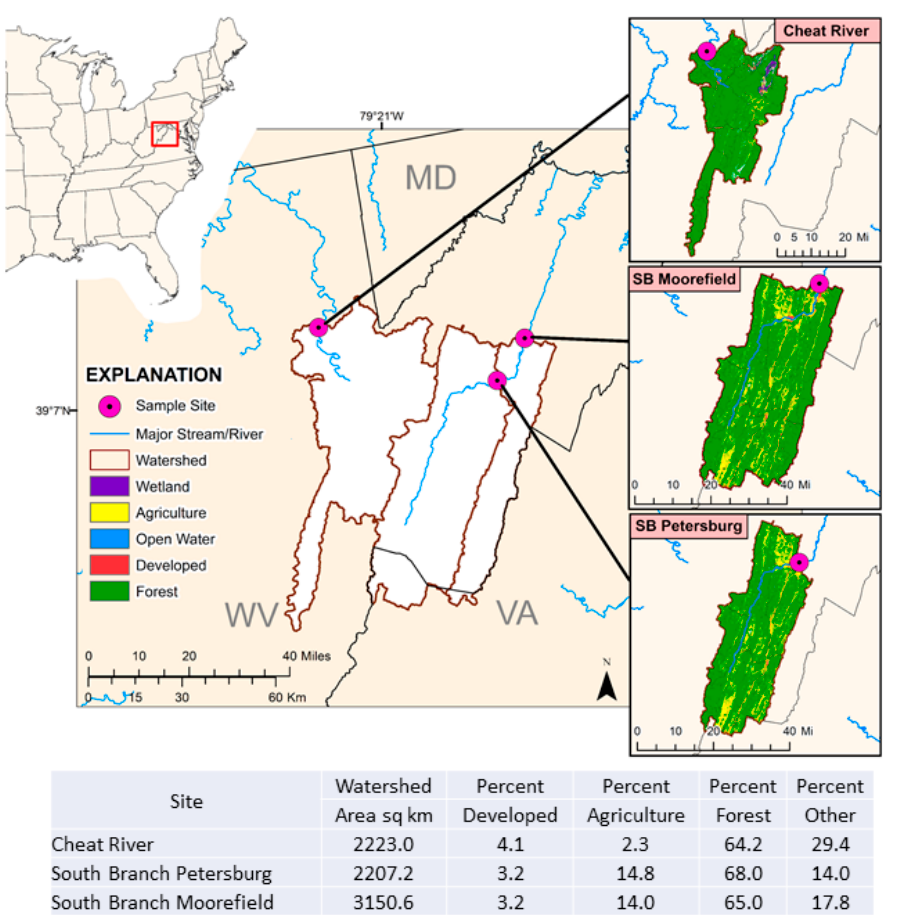
Figure 1. Fish collection sites at Cheat River near Hannahsville, West Virginia (CH); South Branch Potomac near Petersburg, West Virginia (SB1); and South Branch Potomac near Moorefield, West Virginia (SB3) with major land cover in the upstream catchments of study sites.